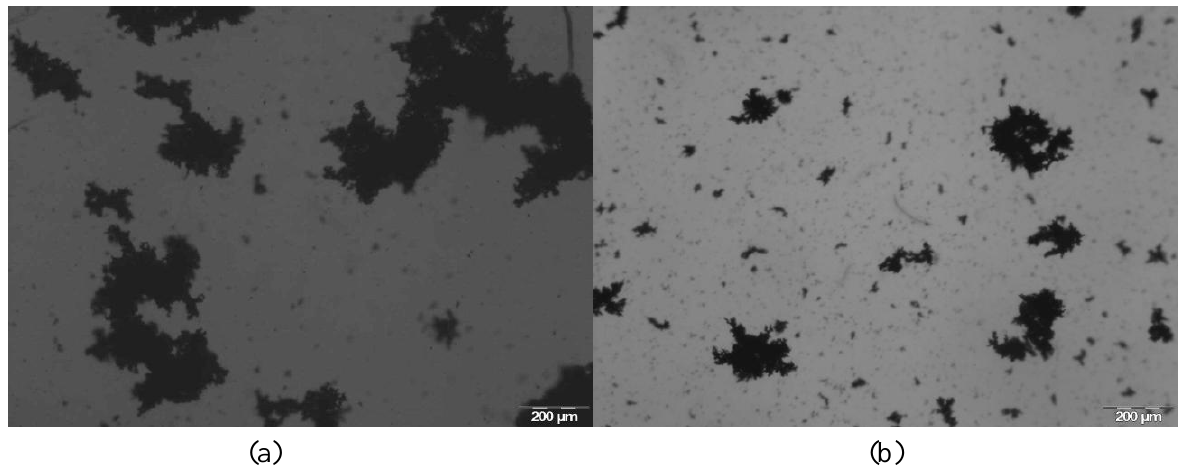
Figure 4. Images of the flocs obtained with E1 (6 mg/g) at two different instants (2 minutes ( a ) and 14 minutes ( b